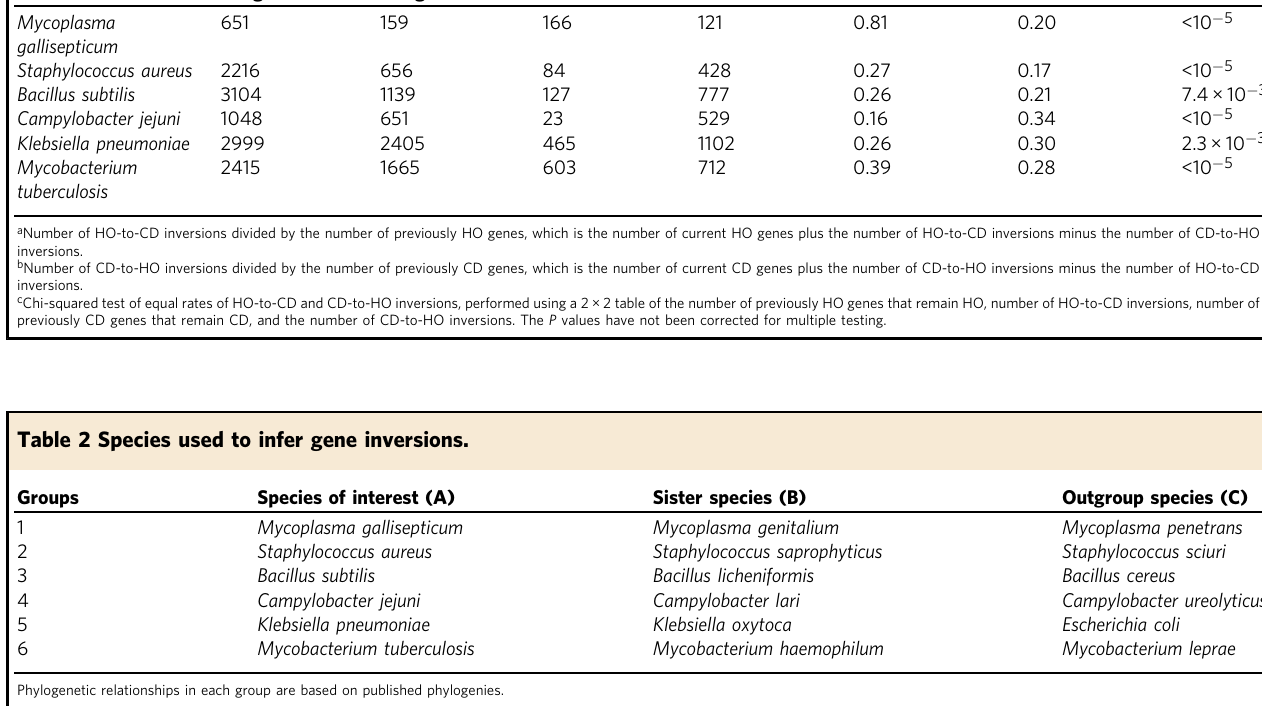
Table 1 HO-to-CD and CD-to-HO inversion rates based on the inversions inferred by Merrikh and Merrikh. Species